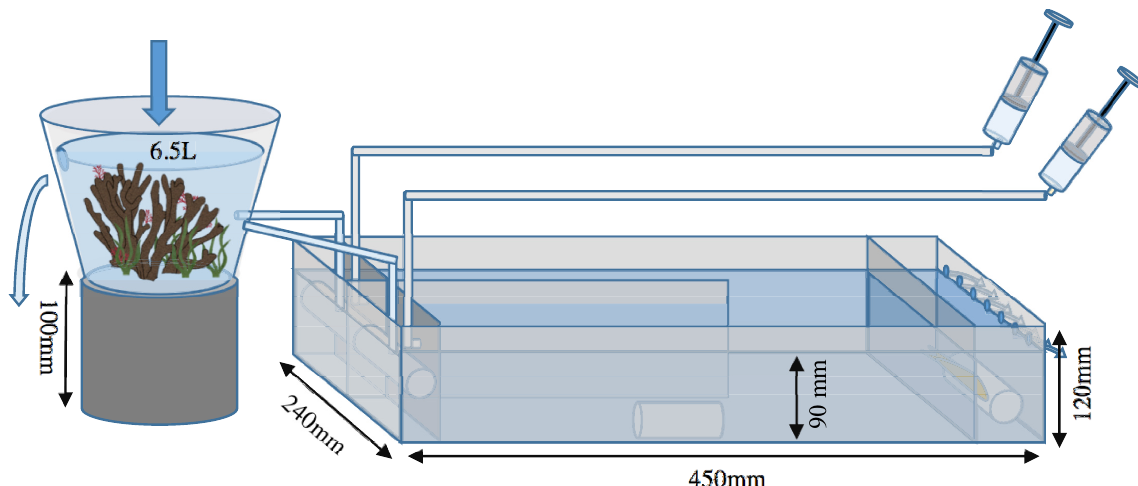
Fig 1. Schematic of the experimental y-mazechoice chamber. Diagramshows coral water treatment reservoir, y-maze and cue injectionsyringes with plumbing.